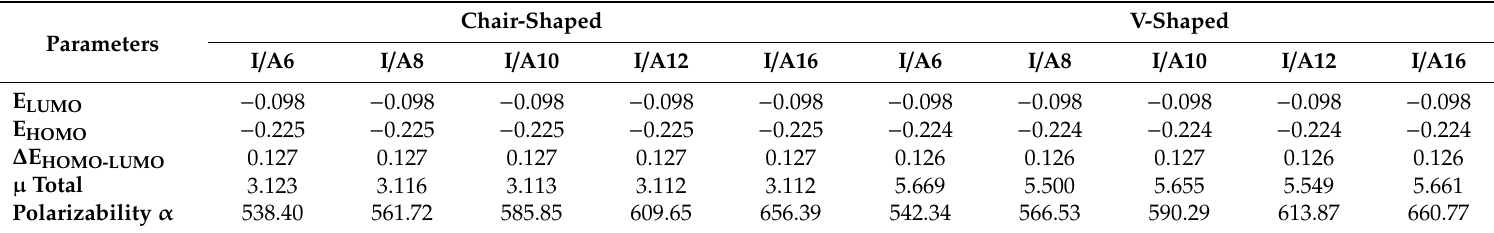
Table 3. FMO Energies a.u., polarizability, α , and dipole moment µ (Debye) of geometrical conformers of HBSMCs, I /